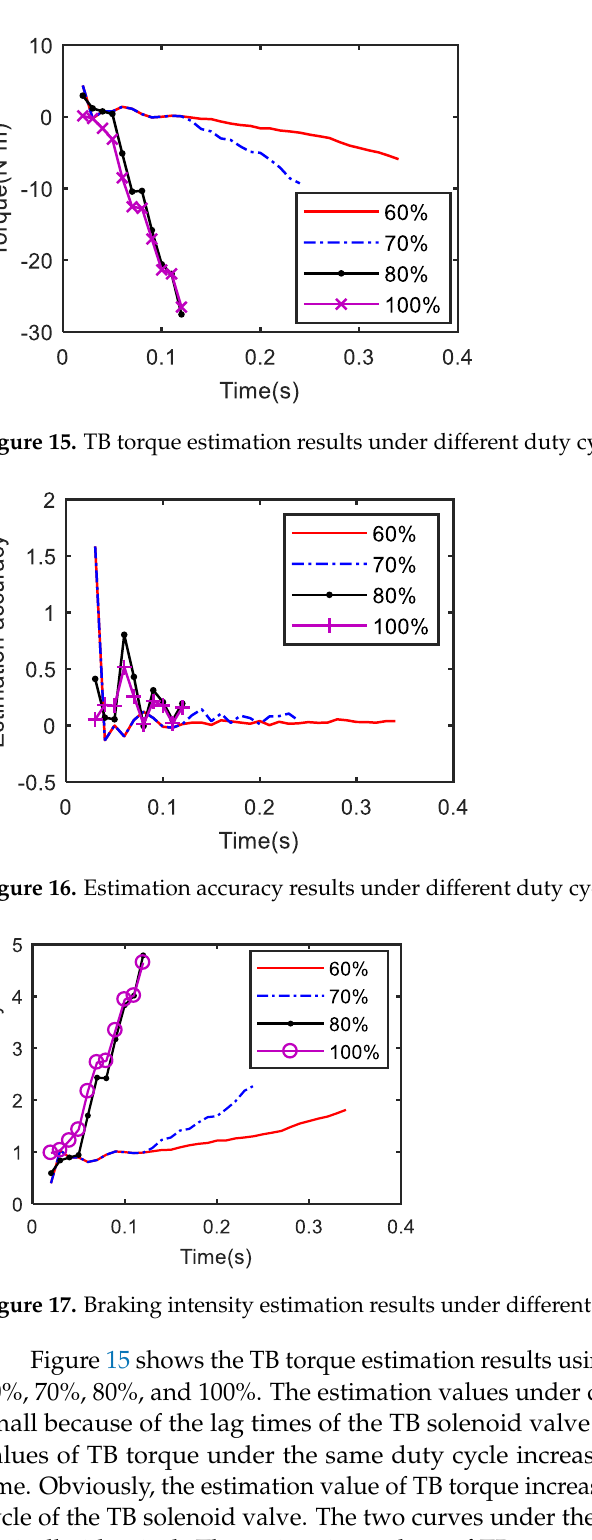
13 of 17 Figure 14. AMT input shaft’s angular acceleration curves under different duty cycles of TB solenoid valve. The braking characteristic parameters of TB action were studied according to the de- celeration processes of AMT input shaft under the duty cycles of 60%, 70%, 80%, and